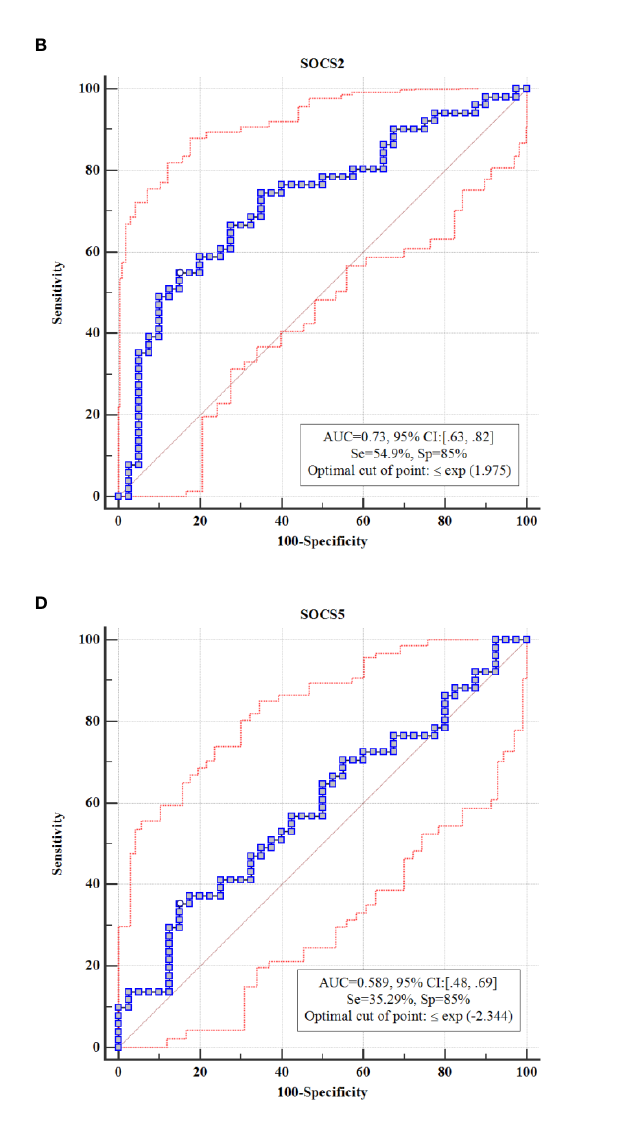
FIGURE 2 | Results of ROC curve analysis for SOCS1 (A) , SOCS2 (B) , SOCS3 (C) and SOCS5 (D) ,